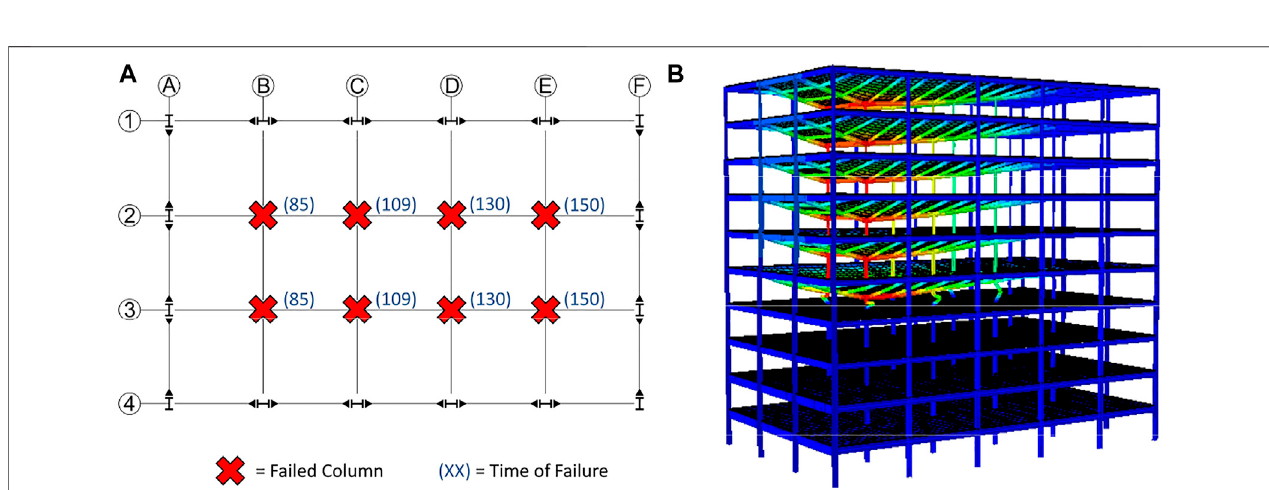
FIGURE 8 | (A) Column failure summary for Fire Scenario #2 (B) the deformed shape of the structure at 150 min.